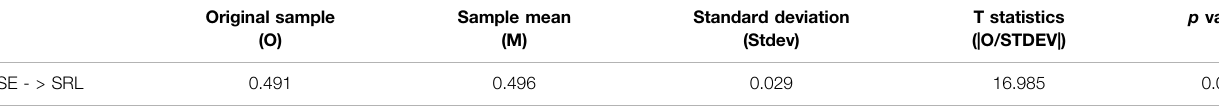
TABLE 6 | Path coef fi cients of SE and SRL.